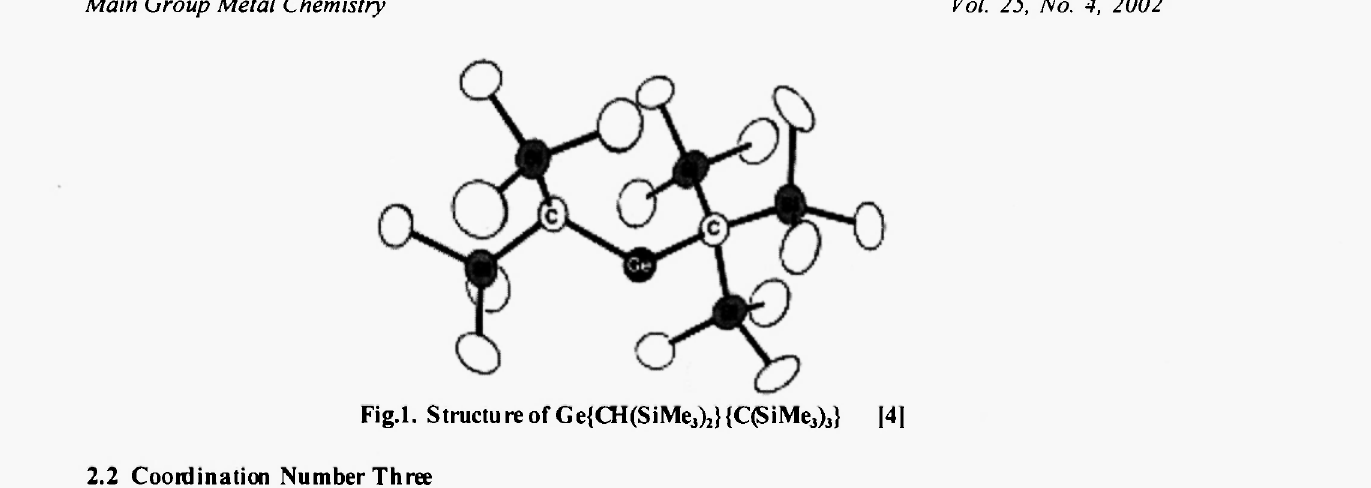
Fig.l. Structure of Ge{CH(SiMe 3 ) 2 }{C(SiMe 3 )3} |4|